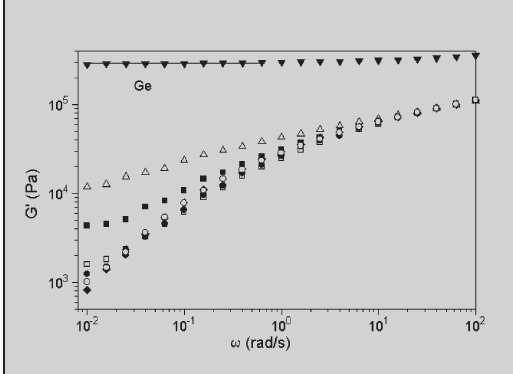
Figure 4: Storage modulus at 160°C as a function of frequency for the iBMA homopolymer ( (cid:122) ), the iBMA-co-MA ( (cid:134) ) and iBMA-co-GMA ( (cid:129) ) copolymers and an unsheared heterogeneous blend ( (cid:139) ). Figure 5: Storage modulus at 160°C as a function of frequency for hetero- geneous blends with different applied shear strains: (cid:139) : γ = 0; (cid:129) : γ = 200; (cid:122) : γ = 450; (cid:134) : γ = 790; (cid:132) : γ = 1100, (cid:139) : γ = 2170. The temperature of the pre-shear step was 125°C. All samples stayed four hours at that temperature before being heated up to